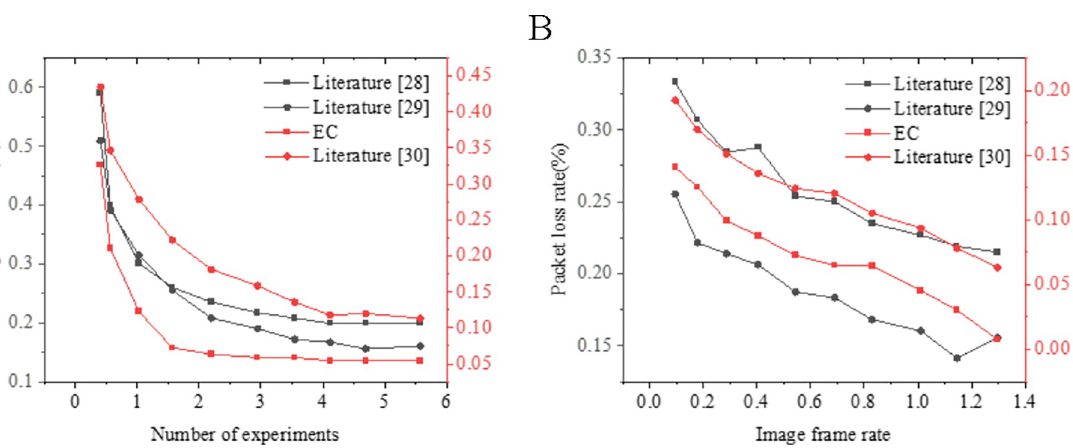
Fig 4. Frame loss results of different landscape design